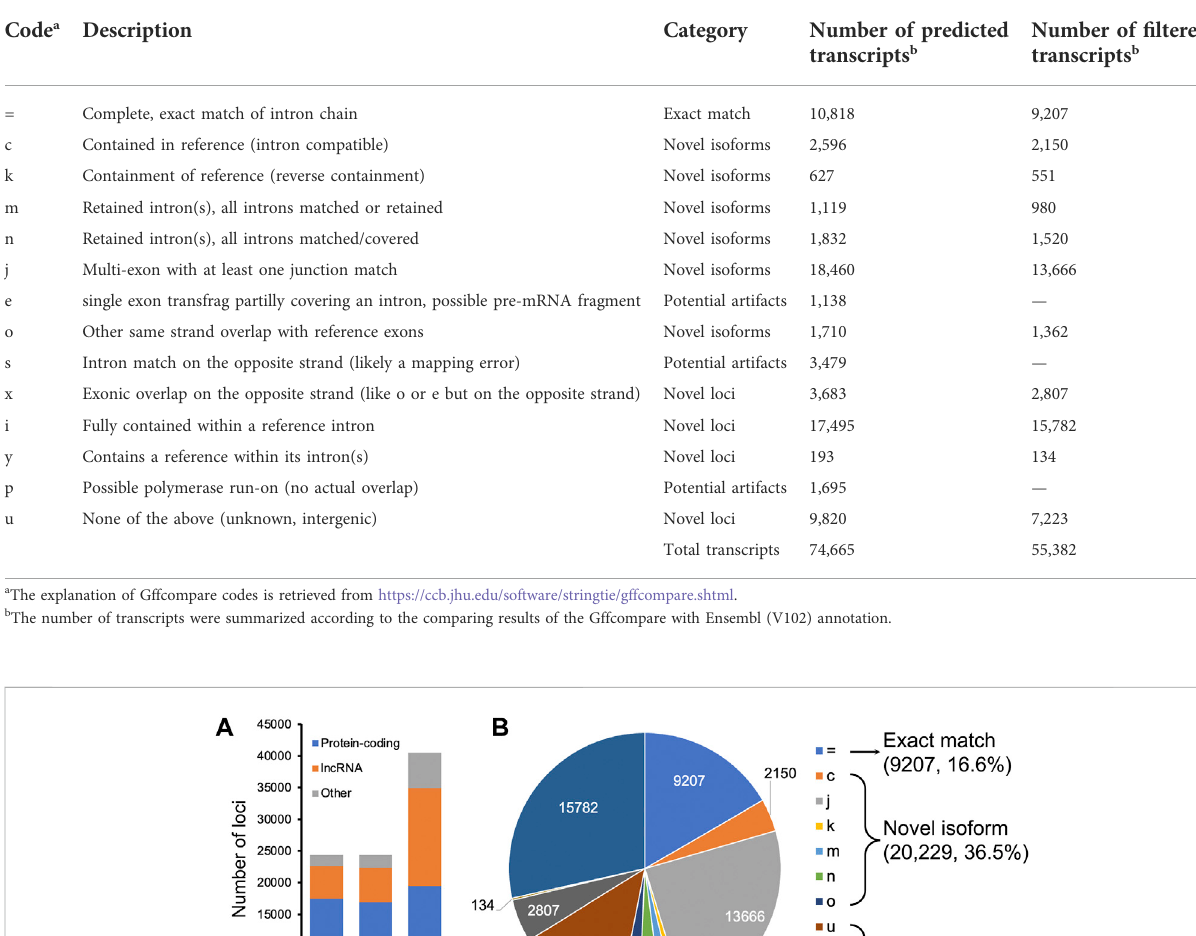
TABLE 2 Number of transcripts as a function of Gffcompare codes.